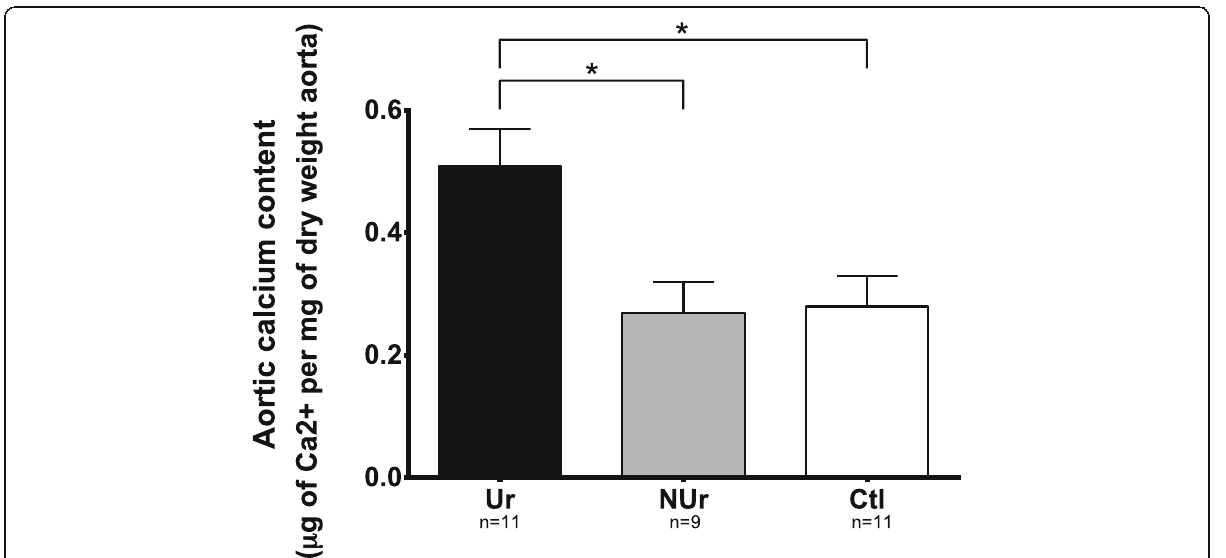
Fig. 3 Aortic tissue calcium content. Values of total aortic tissue calcium content in microgram of Ca 2+ per milligram of dry weight aorta in uremic ApoE − / − mice (Ur, n = 11), non-uremic ApoE − / − mice (NUr, n = 9), and control Bl6 mice (Ctl, n = 11). Data are expressed as mean ± SEM. * p <